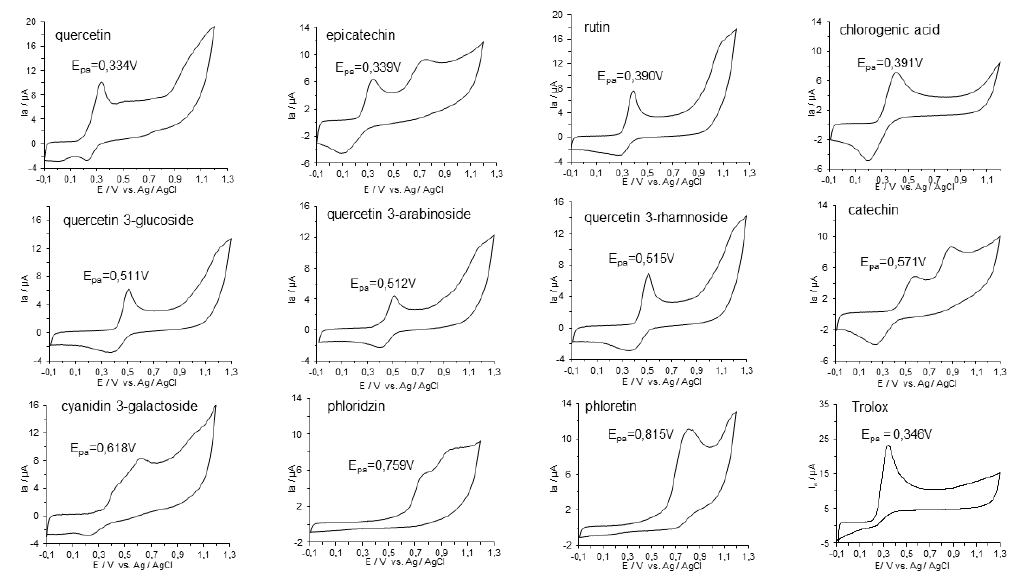
Figure 3. Cyclic voltammograms of 0.25 mM of standard solutions (final concentration) of phenolic compounds in apple cultivars identified by HPLC–DAD–MS / MS analysis in Britton–Robinson